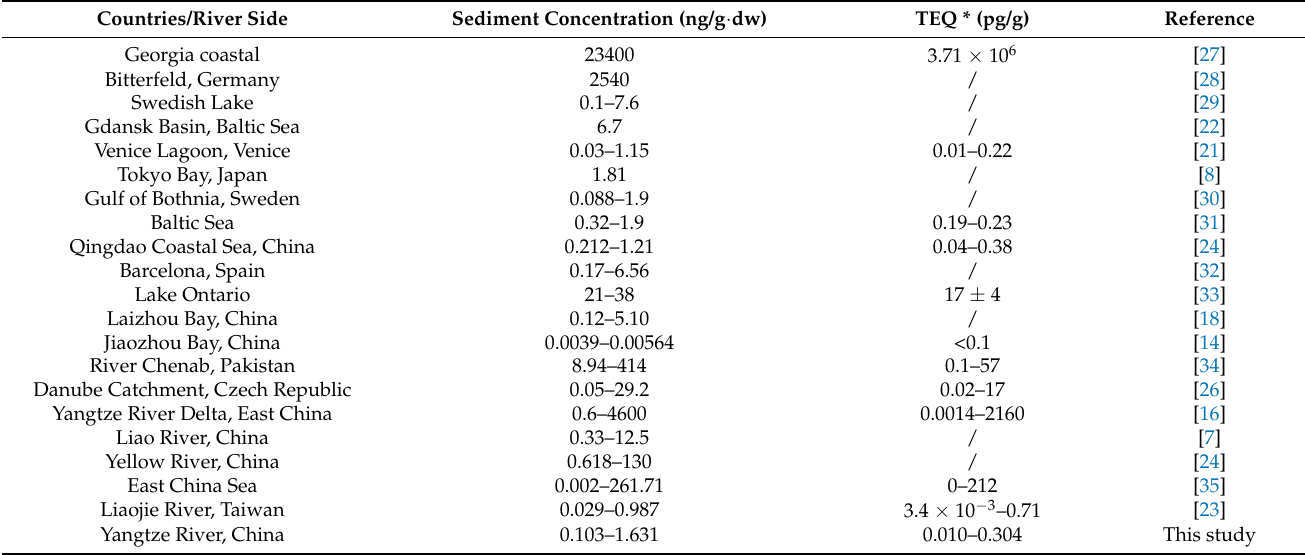
Table 1. Polychlorinated naphthalene levels reported in other parts of the